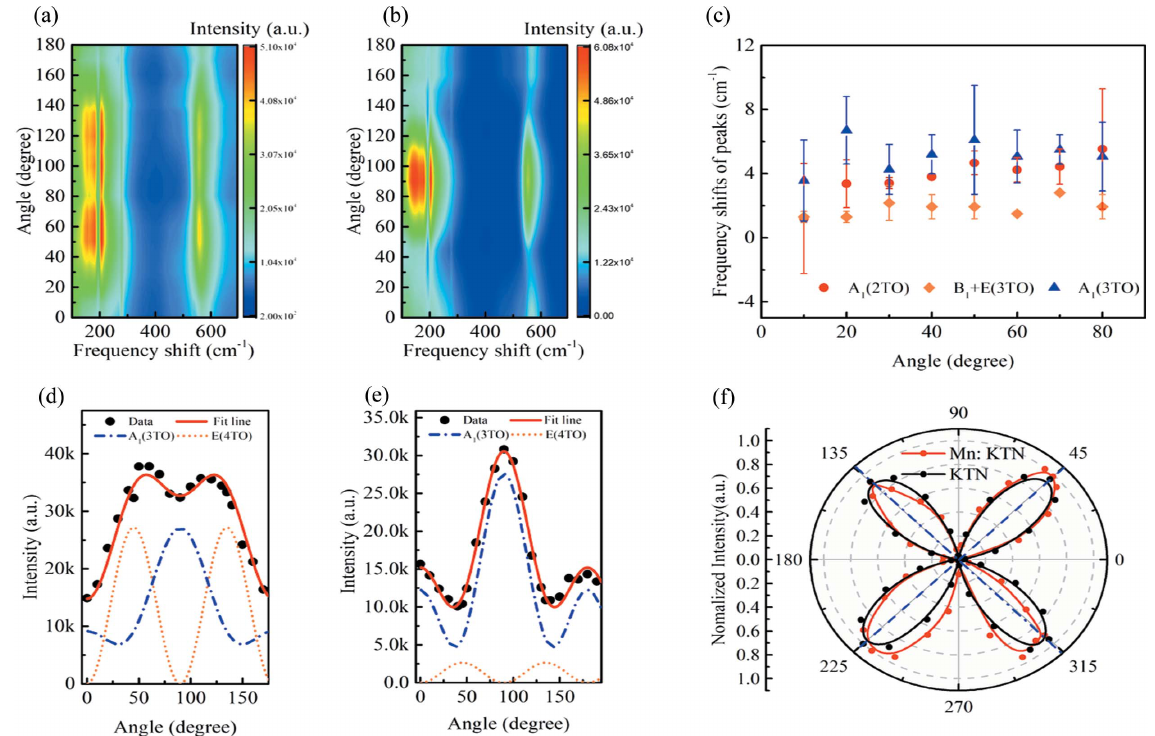
Figure 4 Changes of Raman spectra induced by Mn doping. Angular-dependent Raman spectra of ( a ) Mn-doped and ( b ) pristine KTN in VV configuration. ( c ) Frequency shifts of the peaks of the A 1 (2TO), B 1 +E(3TO) and A 1 (3TO) modes between KTN and Mn-doped KTN. Error bars represent the standard deviation from at least three independent measurements. Angular dependences of the A 1 (3TO) and E(4TO) modes and fitting results of ( d ) Mn-doped and ( e ) pristine KTN in the VV configuration, respectively. ( f ) Angular dependence of the A 1 (3TO) mode in the VH configuration in polar